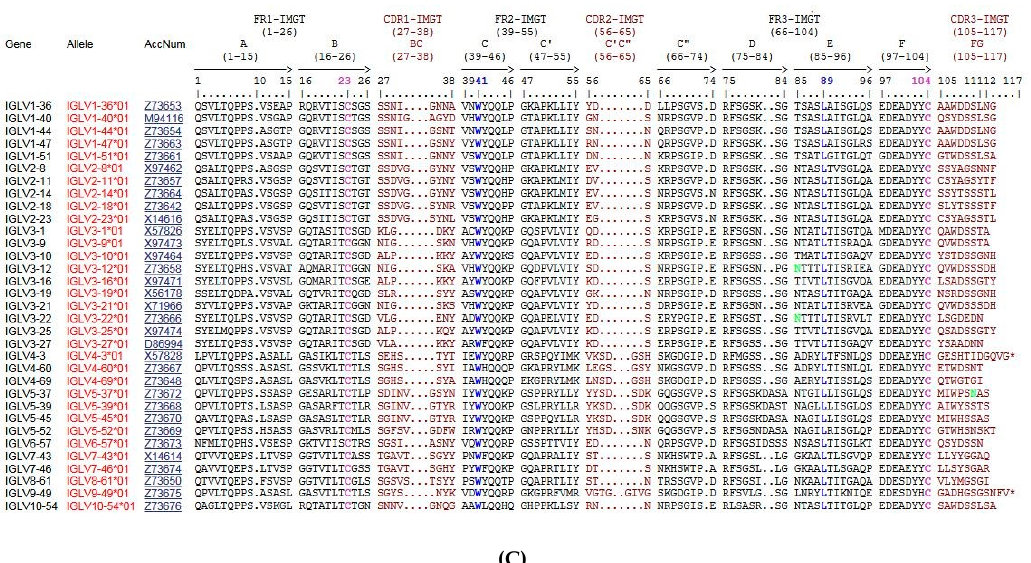
Figure 22. Protein displays of the Homo sapiens IGH, IGK and IGL V-REGION. Only the *01 allele of each functional or ORF V-REGION shown. ( A ). IGHV genes are listed per subgroup and, for each subgroup, increasing numbers corresponding generally to their position from 3 ′ to 5 ′ in the locus [2,237]. ( B ). IGKV genes are listed per subgroup and, for each subgroup, increasing numbers corresponding generally to their position from 3 ′ to 5 ′ in the locus, with the letter D for genes of the distal V-CLUSTER [2,237]. The IGKV2-29 gene is not represented the *01 allele being a pseudogene. For information, the IGKV2-29*02 F differs from IGKV2D-29*01 by P49 > S, N66 > S, S107 > G, Q109 > H [2,237]. ( C ). IGLV genes are listed per subgroup and, for each subgroup, increasing numbers corresponding generally to their position from 3 ′ to 5 ′ in the locus [2,237]. The header of the IMGT Protein display of V-REGION comprises 7 lines. Line 1: FR-IMGT and CDR-IMGT. Line 2: start and end positions of FR-IMGT and CDR-IMGT, e.g. (1-26). Line 3: name of strands (A, B...) and loops (AB, BC...). Line 4: start and end positions of strands, e.g. (1-15). Line 5: arrows (for the strands). Line 6: positions according to the IMGT unique numbering for V-DOMAIN and V-LIKE-DOMAIN [41]. Line 7: Pipes for the start and end positions of strands and loops and highlighted positions, dots for the other positions (dots indicate gaps according to the IMGT unique numbering [41]). The four conserved amino acids 23 (1st-CYS), 41 (CONSERVED-TRP), 89 (hydrophobic) and 104 (2nd-CYS) are highlighted (C23 and C104 in pink, W41 and hydrophobic 89 in blue). N (Asn, asparagine) of potential N-glycosylation sites (NXS/T, where X is different from P) (N-linked glycosylation) is shown in green. (With permission from M-P. Lefranc and G. Lefranc, LIGM, Founders and Authors of IMGT ® , the international ImMunoGeneTics information system ® , http://www.imgt.org).